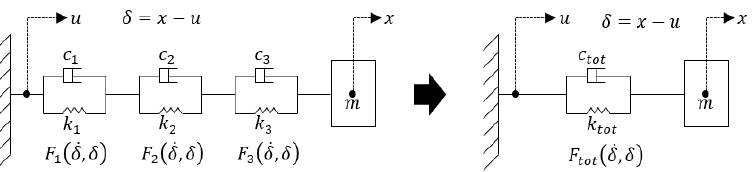
Figure 10. Linear mass-spring-damper system for simulating the 4 isolators (4-point fixed, stainless steel, brass, and aluminum integrated).